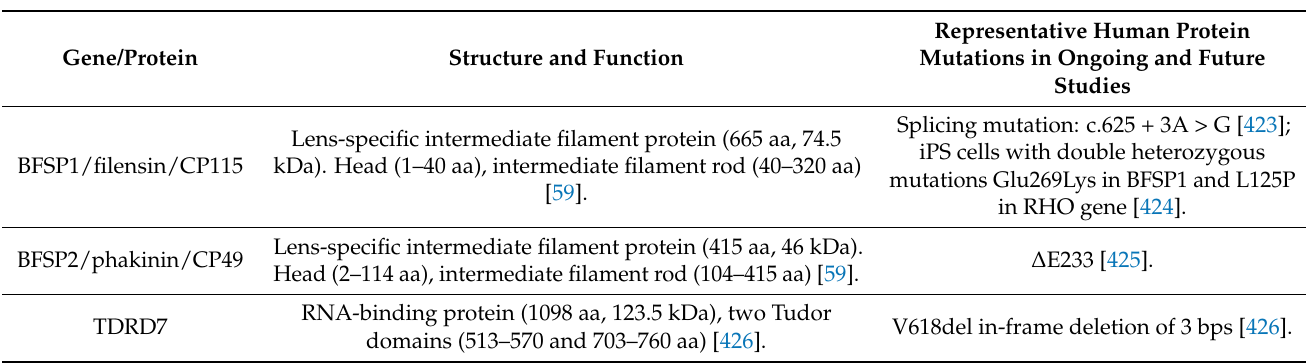
Representative Human Protein Mutations in Ongoing and Future Studies Splicing mutation: c.625 + 3A > G [423]; iPS cells with double heterozygous mutations Glu269Lys in BFSP1 and L125P in RHO gene [424].